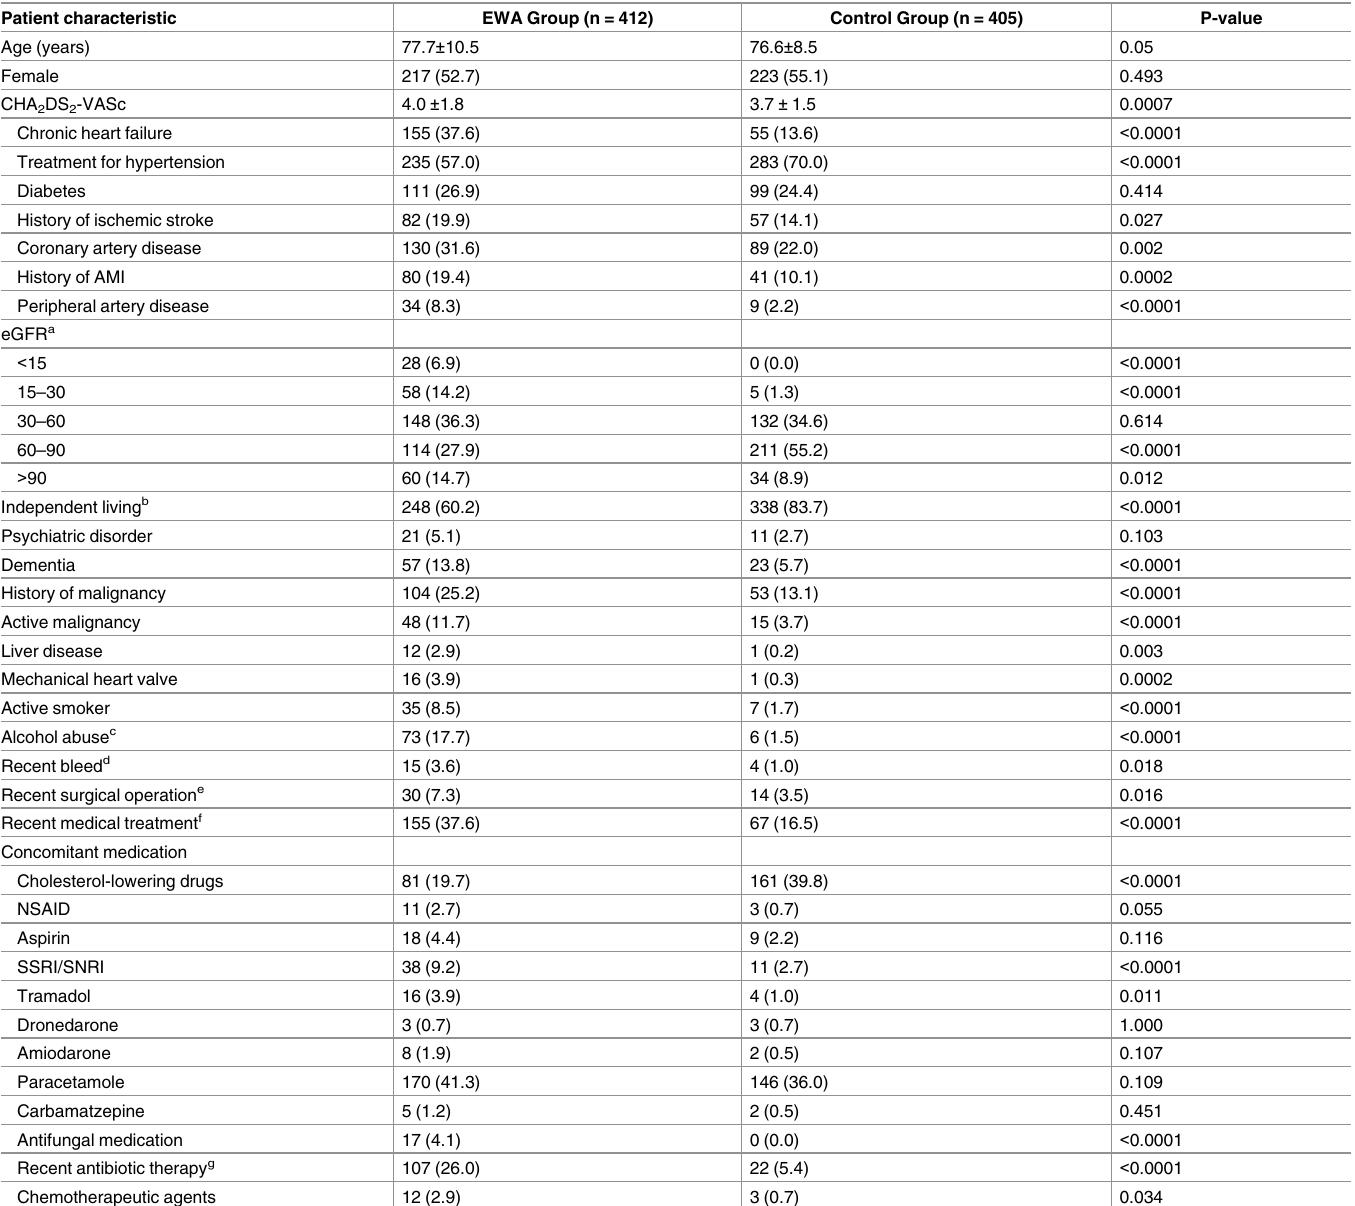
Table 1. Patient